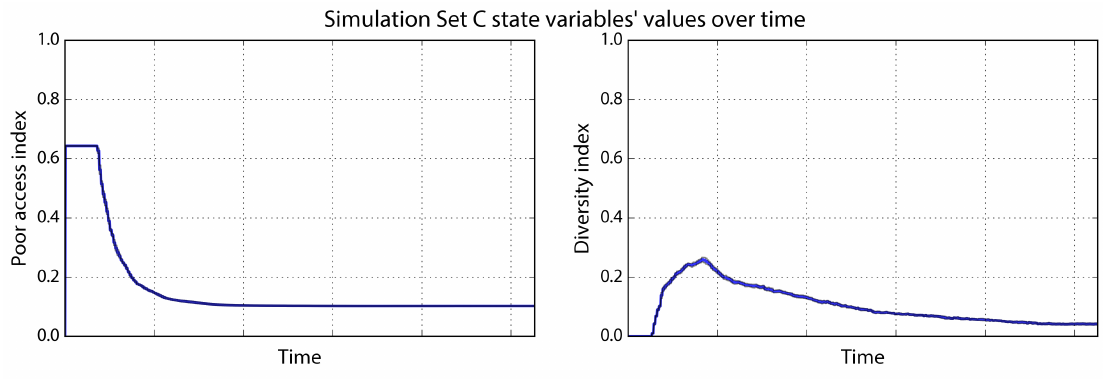
Figure 6. Set C’s state variables from initialization through the end of the simulation, with mean value (blue) and 95% confidence interval (gray) across 50